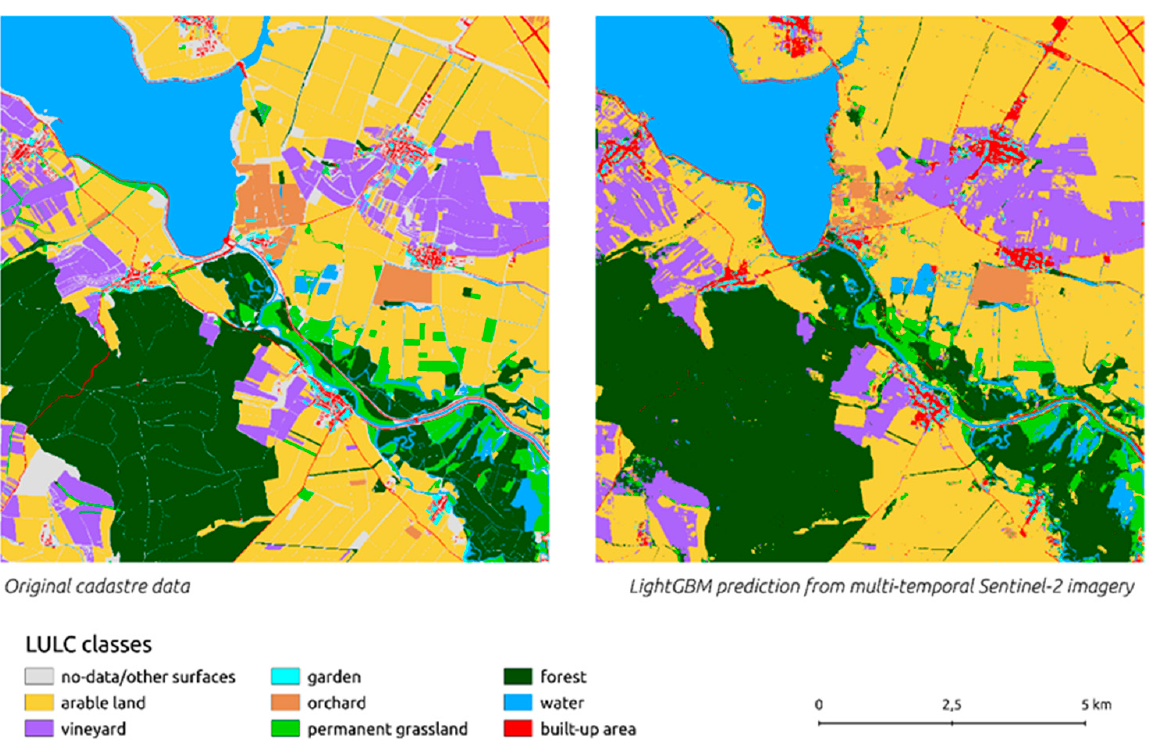
Figure 6. Comparison of original cadaster data and the LightGBM prediction. Sources: Sentinel-2 imagery from 30.3 to 16.10 [80], Czech cadastral map [85].